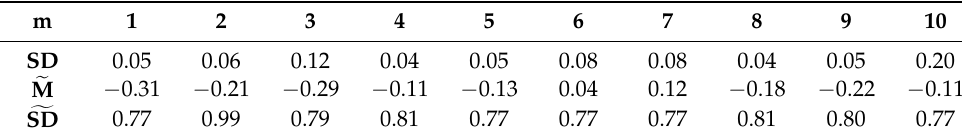
Table 2. Scaling of the sensor data: second